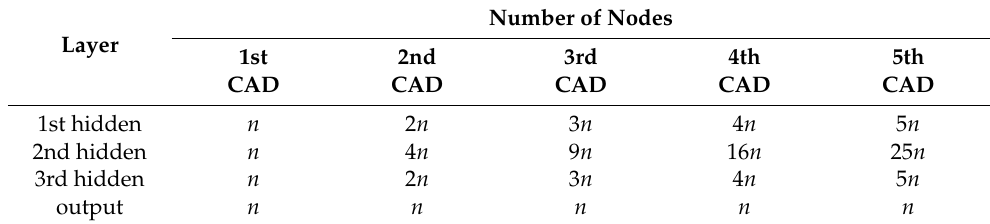
Table 6. The number of nodes in PAD with 5 CADs.